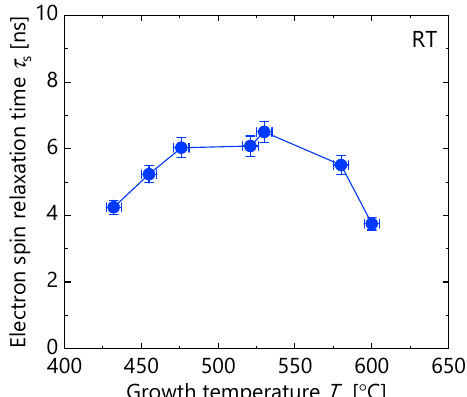
Figure 8. Growth temperature dependence of electron spin relaxation times ( τ s ) measured at RT.